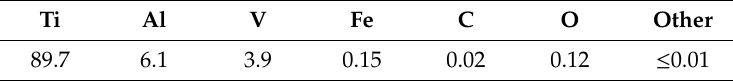
Table 1. Chemical compositions of the Ti-6Al-4V